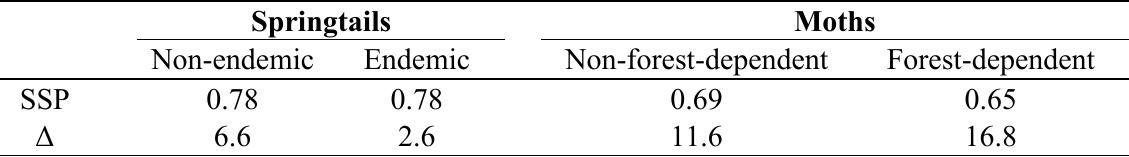
Table 3. Smith, Solow and Preston (SSP) index and relative distance in species richness ( ∆ ) between sites (sub-natural forest and plantation), per data set of springtails and